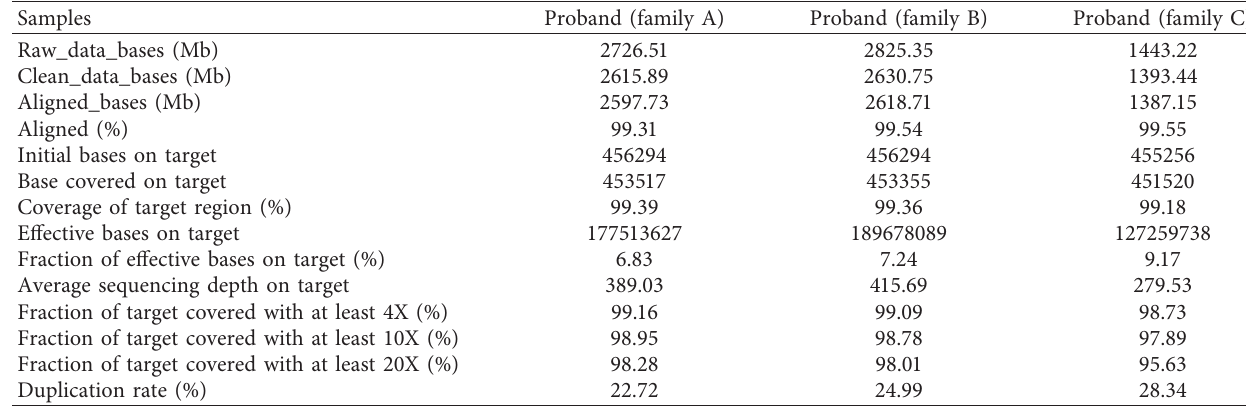
Table 2: Summary of probands sequencing data in three families.